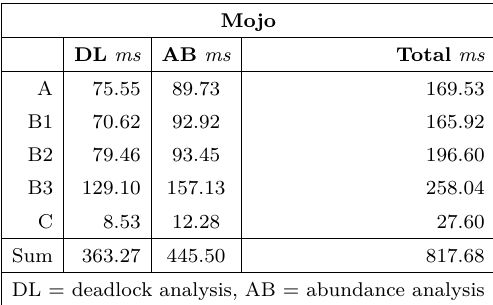
Figure 31. Distribution of the analysis times for Mojo